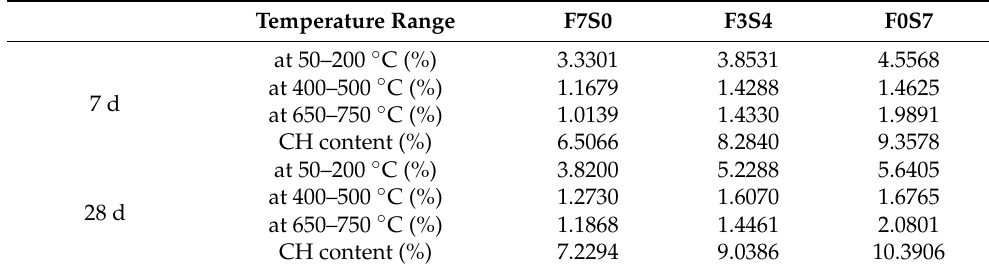
Table 5. Weight losses of the LCFLS system.